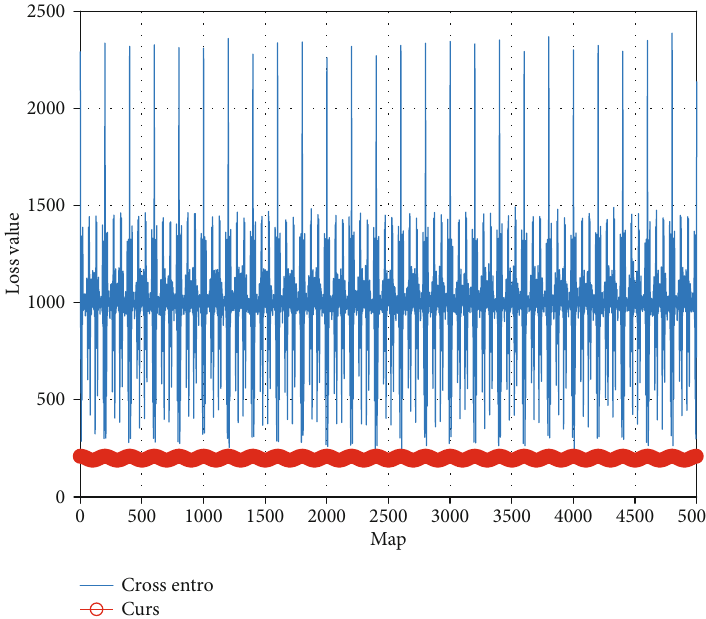
Figure 4: Comparison of loss functions of cross